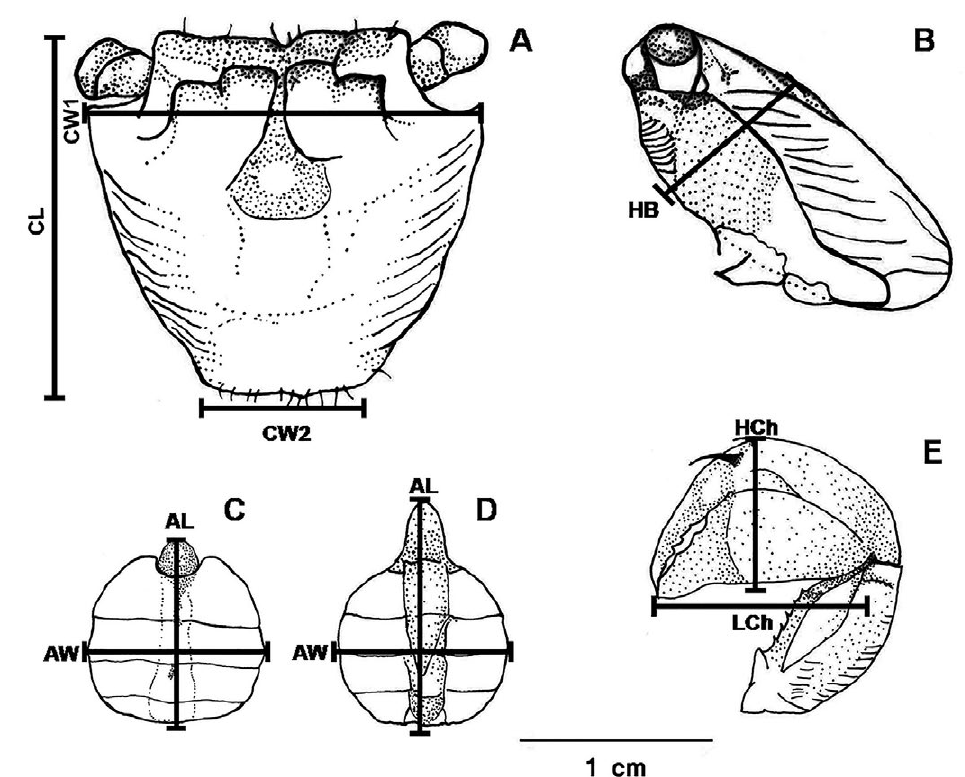
Fig. 2. – Illustration of morphological dimensions measured in Aratus pisonii . A, dorsal view of the carapace (CL, carapace length; CW1, CW2, maximum and minimum carapace width); B, height of body (HB); C, female abdomen; D, male abdomen (AL, abdomen length; AW, abdomen width); E, lateral view of left cheliped, length cheliped (LCh) and height cheliped